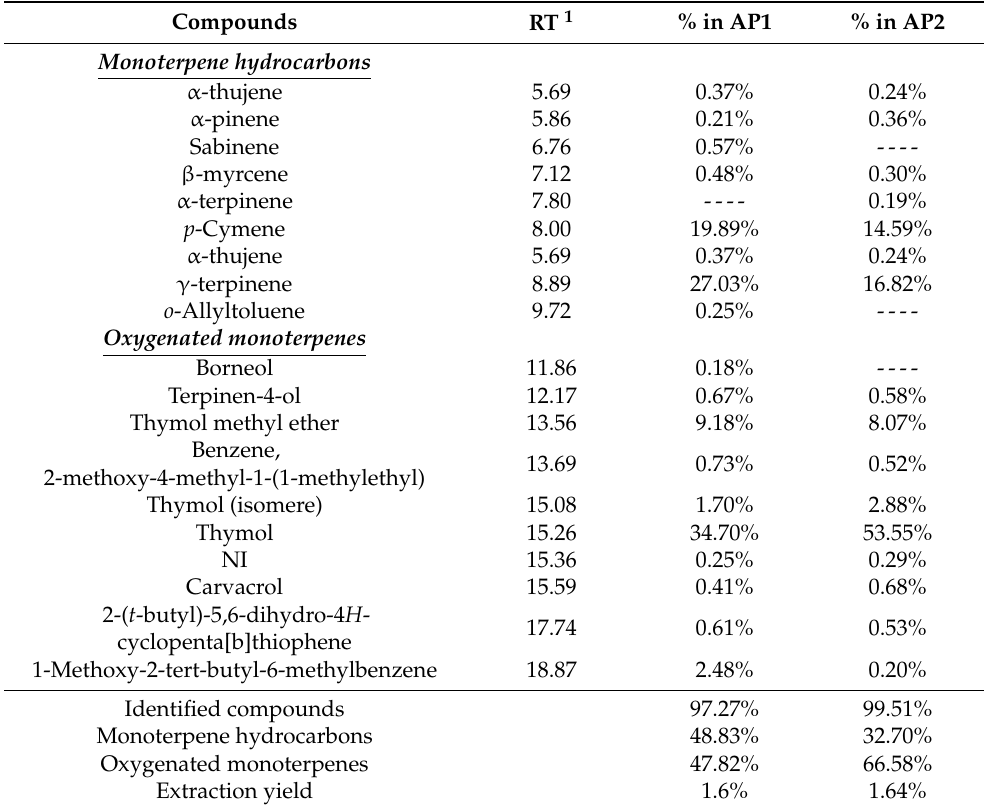
Table 3. Chemical composition (%) of essential oils of A. pusilla using